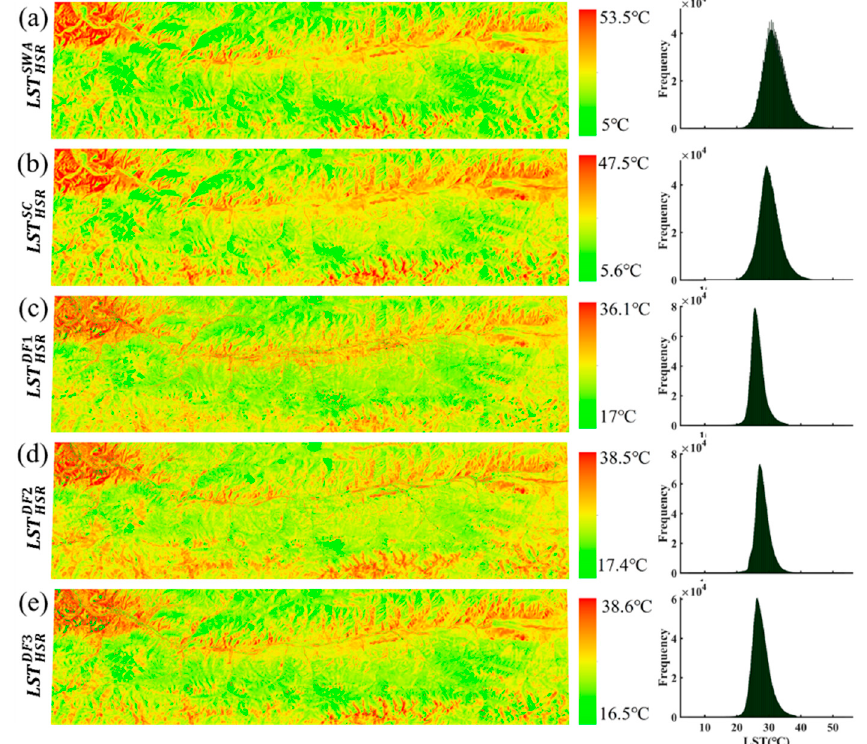
Figure 11. The spatial distribution and frequency histogram of reference LSTs ( a , b ) and the fused LSTs ( c – e ) in Case 2 on 16 July, 2017.